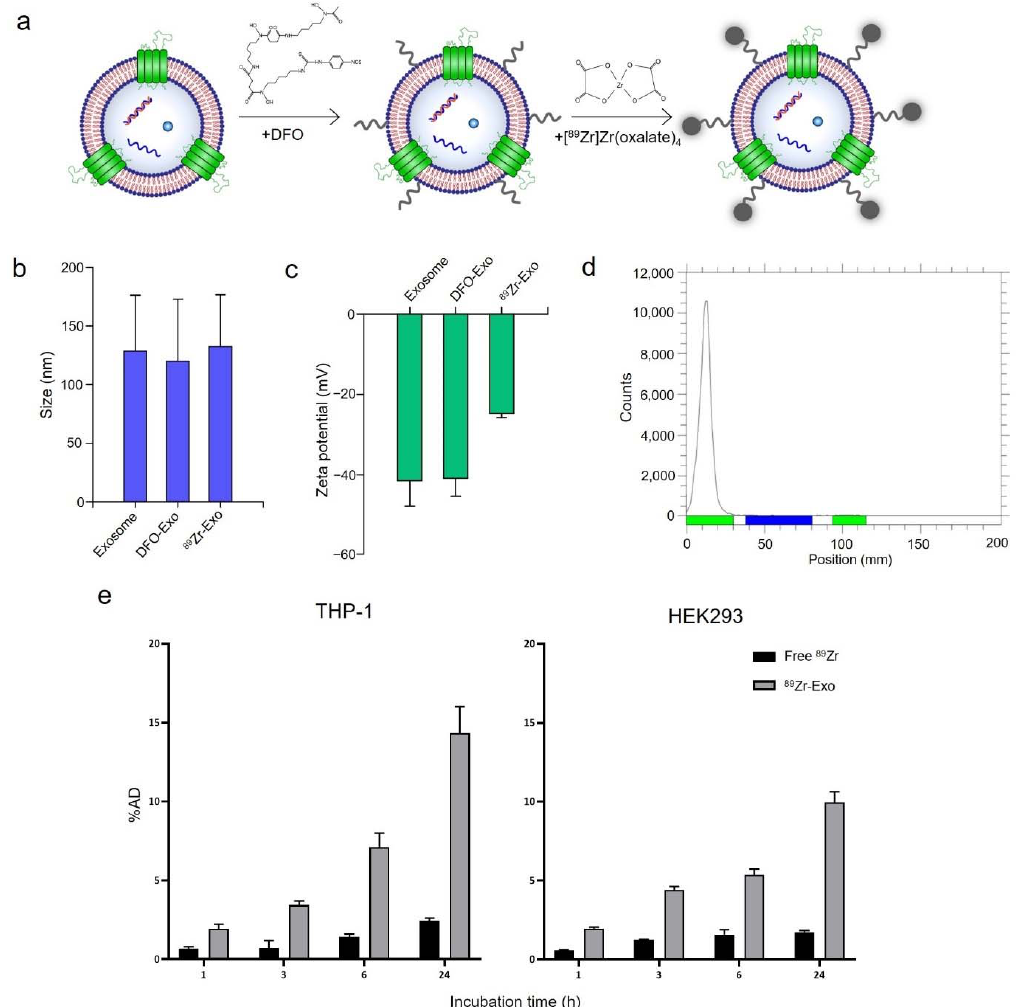
Figure 1. Radiolabeling GMP-grade exosomes with 89 Zr. ( a ) Schematic of the method for labeling the surface of exosomes with 89 Zr. ( b ) 89 Zr-Exo size was measured using NTA shown as mean ± standard deviation (SD). ( c ) Zeta potential of 89 Zr-Exo was measured using Zetasizer Nano ZS shown as mean ± SD. ( d ) Radiochemical purity of 89 Zr-Exo was analyzed using radio-TLC. ( e ) In vitro cellular uptake of 89 Zr-Exo was evaluated in the THP-1 and HEK293 cell lines at the indicated time points shown as %AD ± SD .